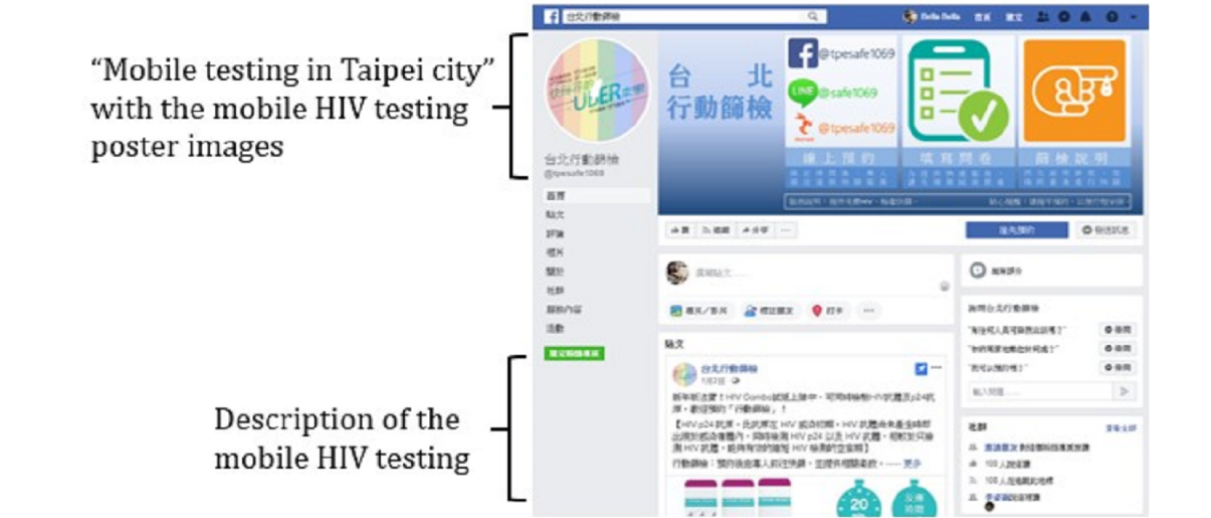
Figure 2. The profile of the mobile HIV testing on the Facebook